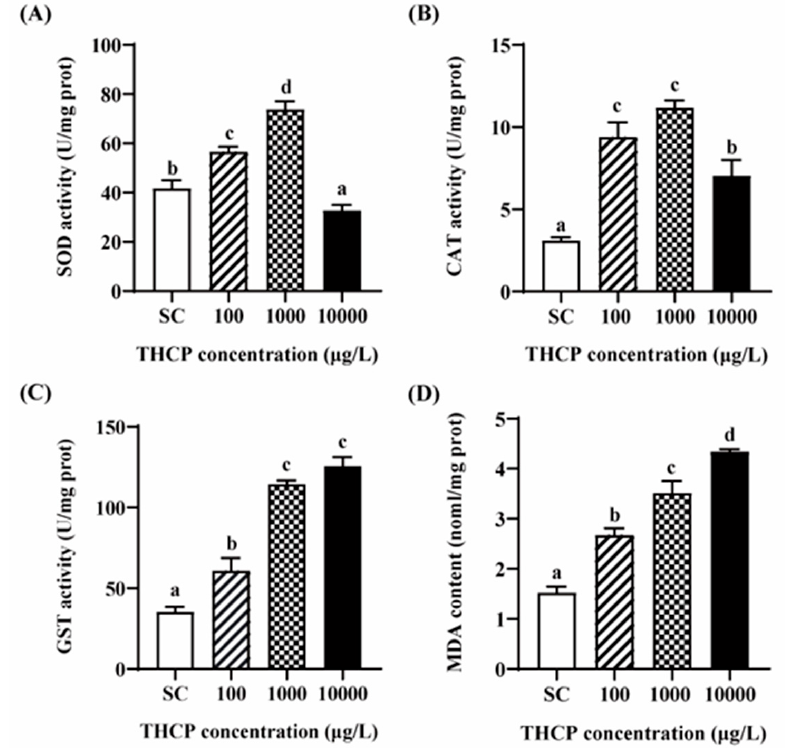
Figure 7. THCP-induced oxidative stress in larvae. ( A ) SOD activity. ( B ) CAT activity. ( C ) GST activity. ( D ) MDA content. One-way ANOVA followed by Tukey’s post hoc tests were used to determine statistical differences. Different letters indicate statistically significant differences between different treatment groups ( p < 0.05).